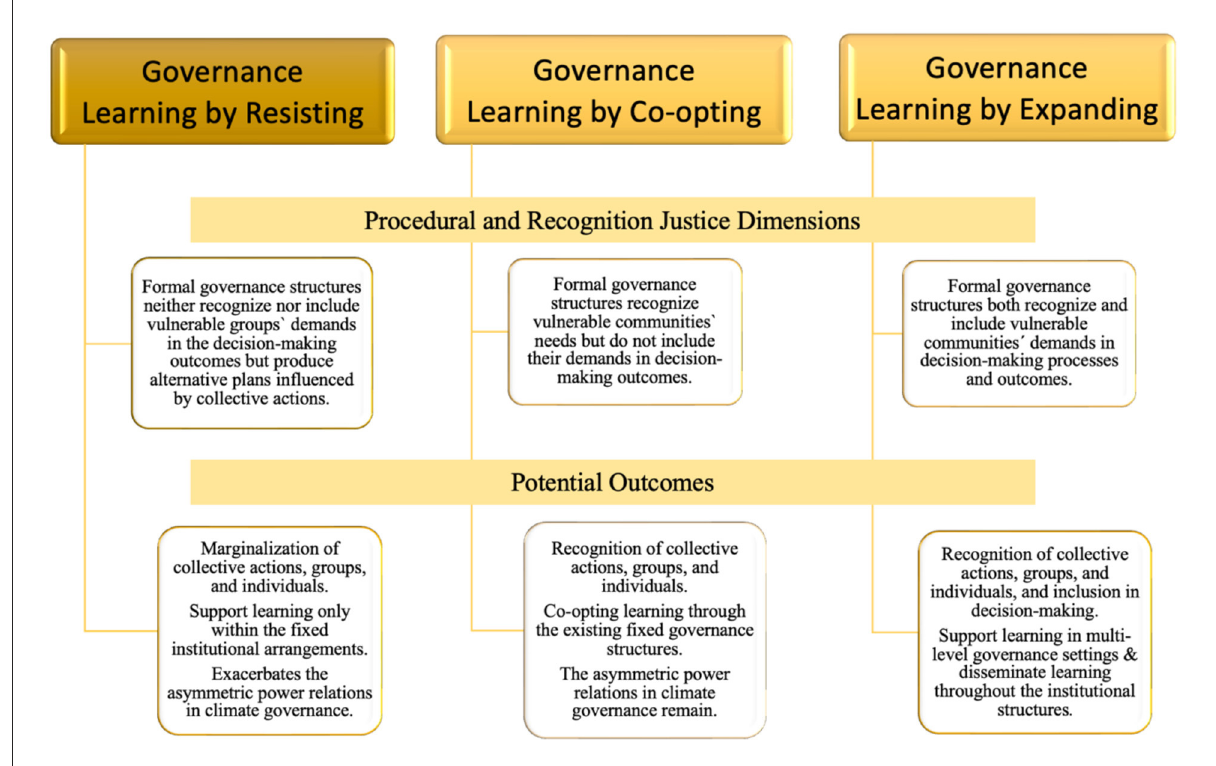
FIGURE1 A three-part governance learning typology for just urban climate